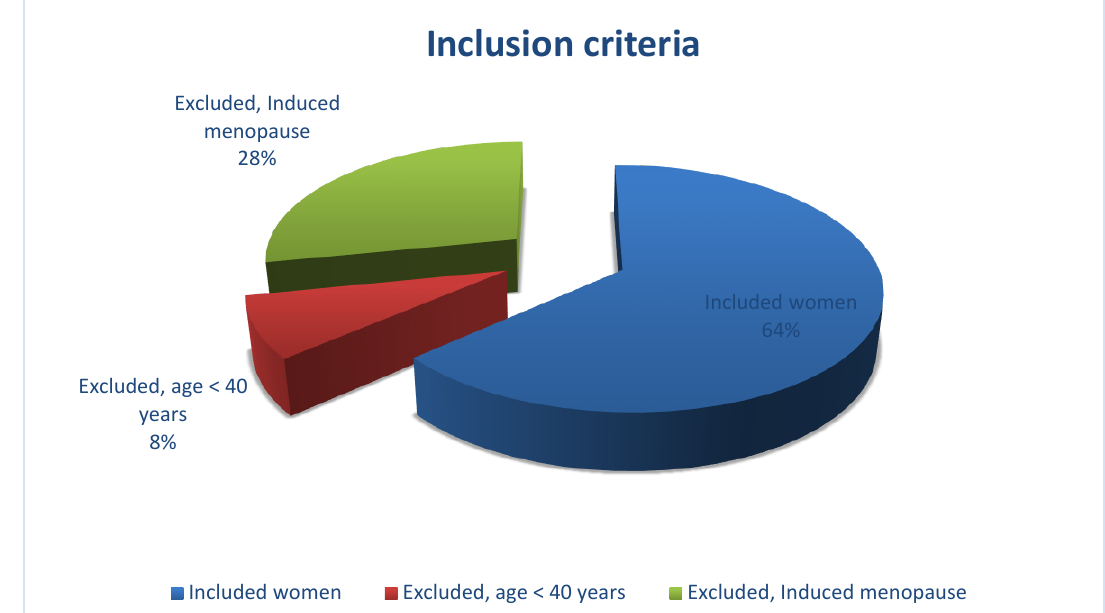
Fig. 1. Inclusion and Exclusion criteria of